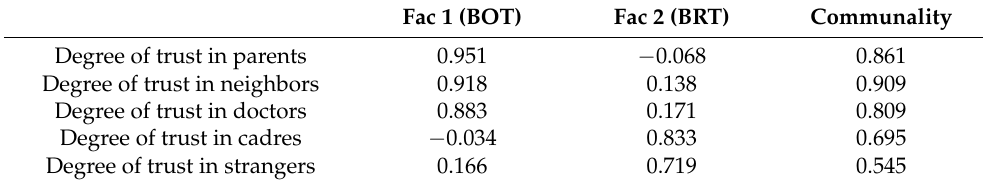
Table 4. Factor loadings of neighborhood social trust indicators.